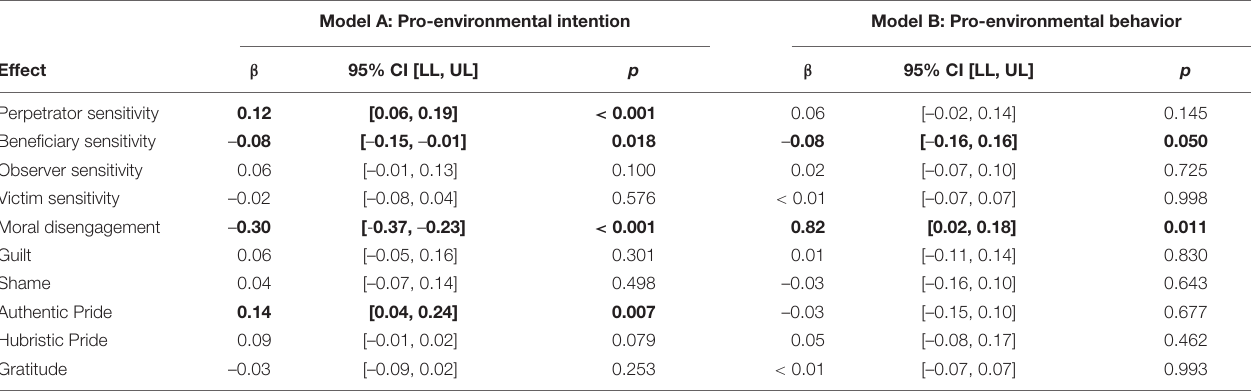
TABLE 6 | Regression analyses of pro-environmental intention and behavior via justice sensitivity, moral disengagement in high carbon behavior, and moral emotion in Study 2. Model A: Pro-environmental intention Model B: Pro-environmental behavior